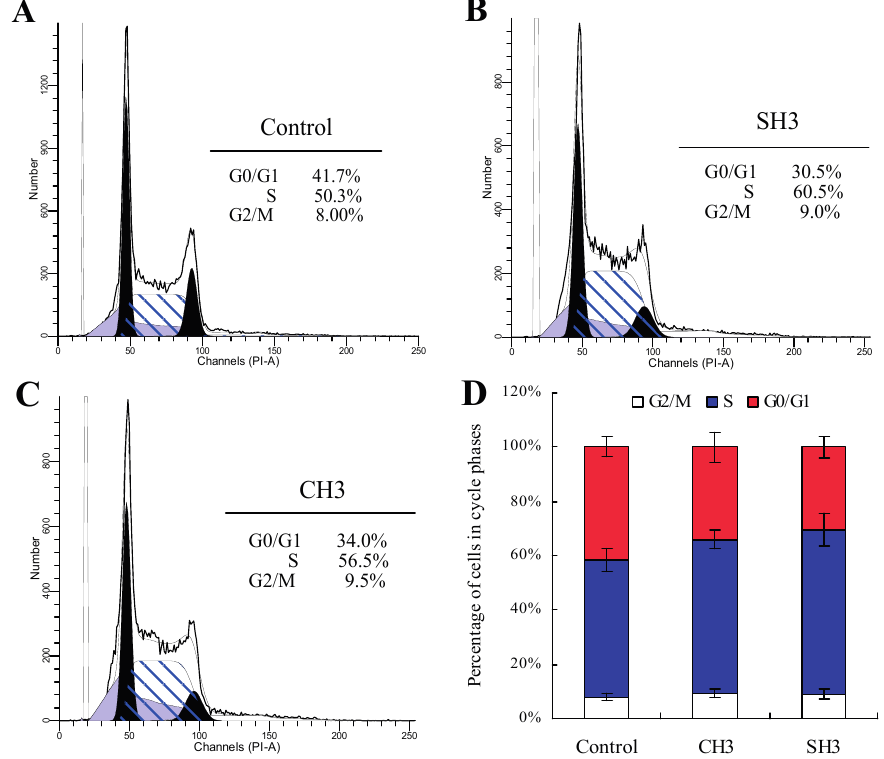
Figure 2. Effects of casein and soy protein and hydrolysates (CH3 and SH3) on cell cycle phase distribution of hFOB1.19 cells. ( A ) Representative histograms of DNA content in control group cells; ( B , C ) Representative histograms of DNA content in the cell incubated with CH3 and SH3 at 0.05 mg/mL for 48 h. Horizontal and vertical axes indicate the relative nuclear DNA content and number of cells, respectively; and ( D ) Percentage of cell populations in G0/G1-, S- and